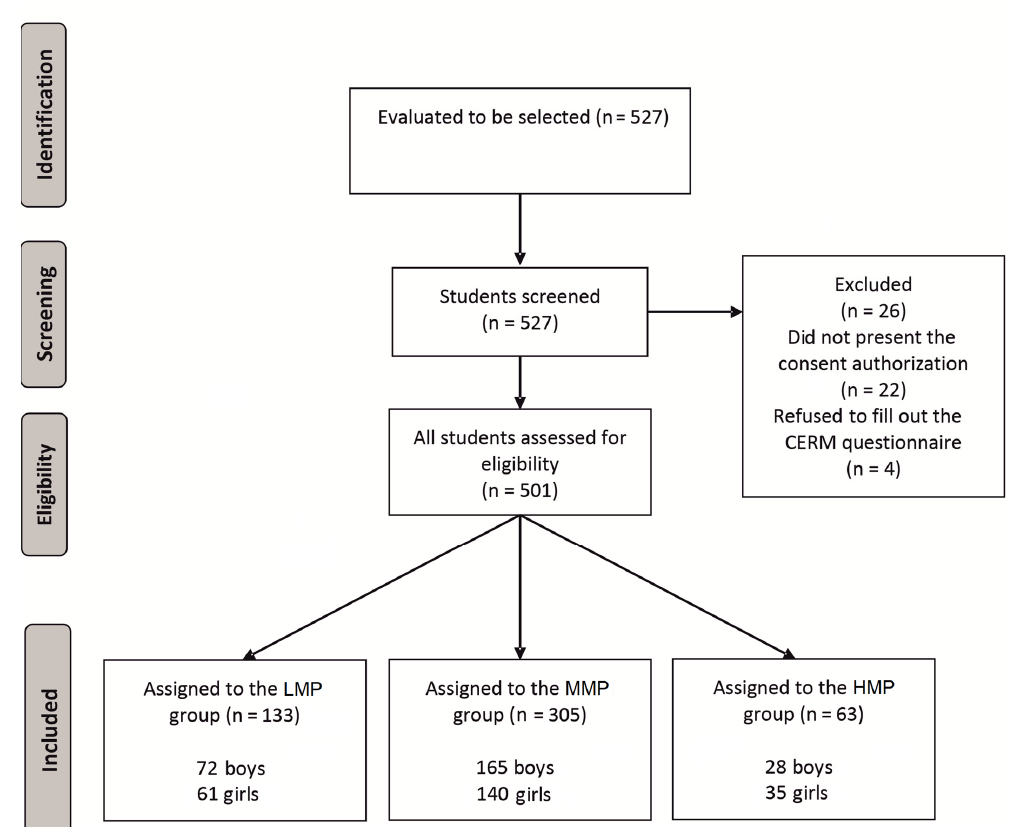
Figure 1. Flow chart of the study subjects. Mobile-Related Experience Questionnaire (CERM) = questionnaire about experiences related to the mobile phone; LMP = low use of mobile phone; MMP = medium use of the mobile phone; HMP = high use of the mobile phone.